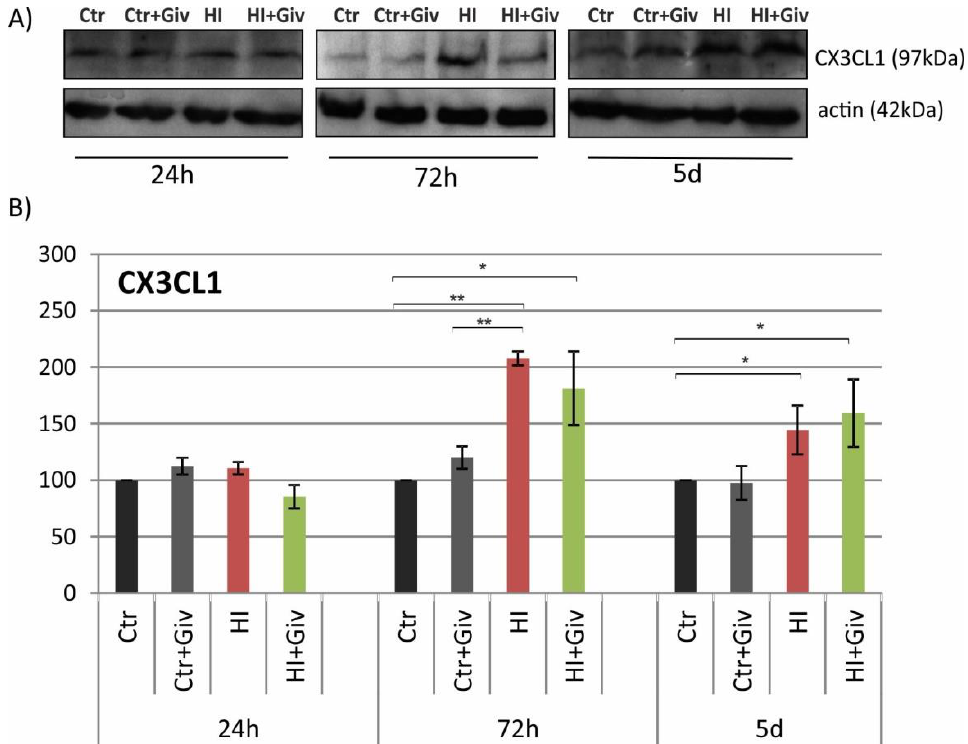
Figure 12. Hypoxia-ischemia increased the level of CX3CL1 in neonatal rat brains. ( A ) Representative immunoblots of CX3CL1 analyzed 24 h, 72 h and 5 days after HI and in age-matched controls. ( B ) The graph shows the statistical analysis of densitometric data presented as a percent of the control value. The intensity of each band was quantified and normalized in relation to the reference protein (actin). The values are the mean ± SD from five animals per group and time point. Note the increased level of CX3CL1 in the hypoxic-ischemic experimental group 72 h and 5 days after insult. The administration of Givinostat after HI did not influence the level of CX3CL1. One-way ANOVA indicates significant differences between the control and HI as well as the control and HI+Giv experimental groups (* p < 0.05; ** p <0.01).